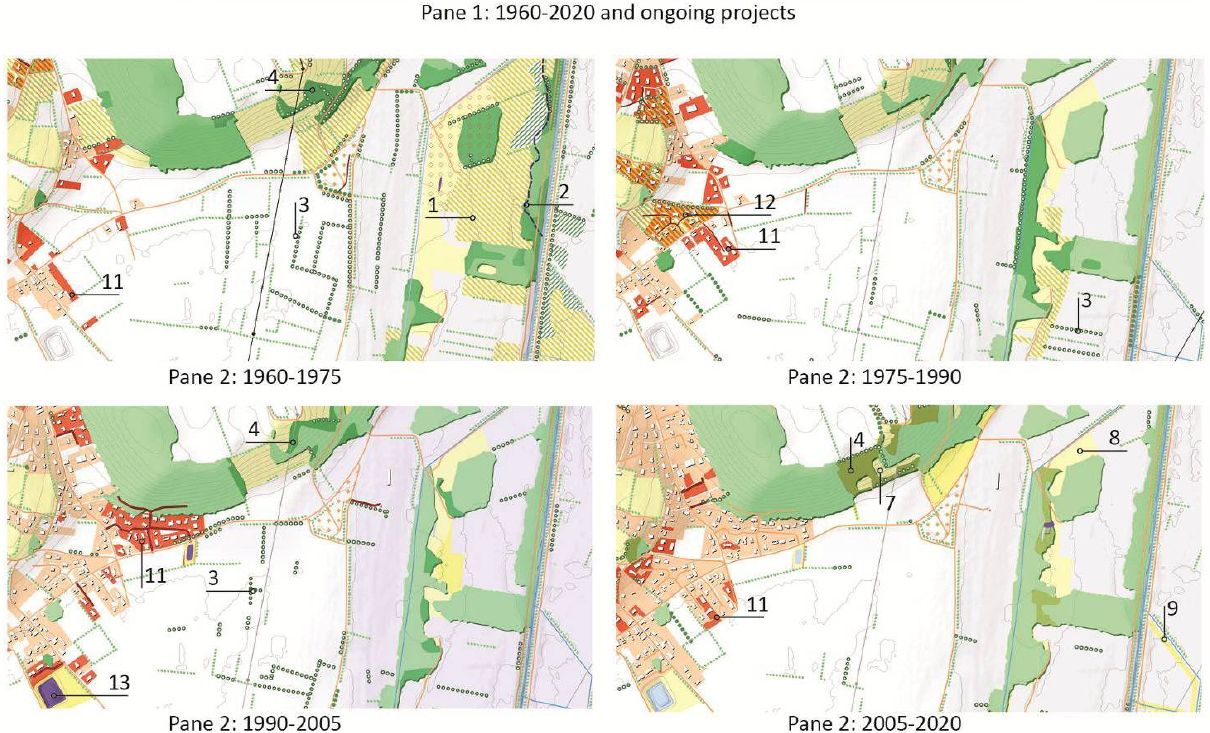
Figure 8. Extract 3 from the palimpsest mapping—The Chesnes agricultural plain (north of the industrial estate). Source: